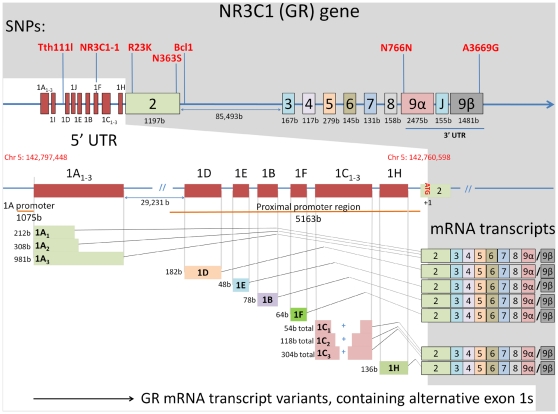
Structure of the GR gene (NR3C1).Map illustrates functional SNPs present in the gene and the generation of GR mRNA variants by inclusion of various exon 1 s in the mRNA 5′ UTR. SNP- single nucleotide polymorphism, UTR- untranslated region, b- base pairs, Chr- chromosome.